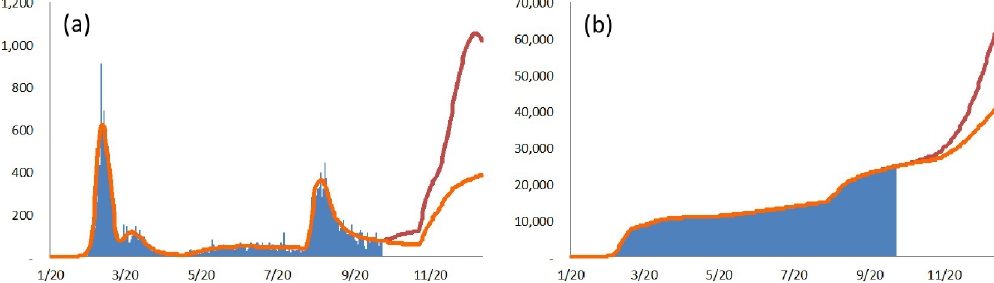
Fig 5. Estimated numbers of confirmed cases in South Korea with/without the shift of q . (a) The point-wise number of actual confirmed cases (blue vertical line), the point-wise number of estimated confirmed cases (red solid line), and the point- wise number of estimated confirmed cases without the shift of the degree of social distancing on October 12 (orange solid line). (b) The cumulative number of actual confirmed cases (blue vertical line), the cumulative number of estimated confirmed cases (red solid line), and the cumulative number of estimated confirmed cases without the shift of the degree of social distancing on October 12 (orange solid